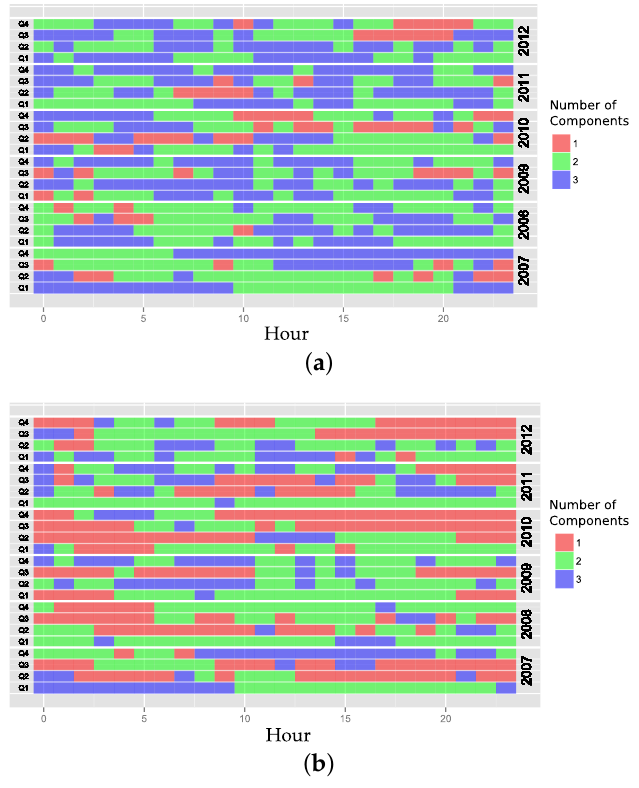
Figure 6. AIC and BIC approaches: optimal number of components for the Weibull mixture model according to the hour of the day for Q1 through Q4 for the years 2007–2012 using wind power generation data. ( a ) AIC approach; and ( b ) BIC